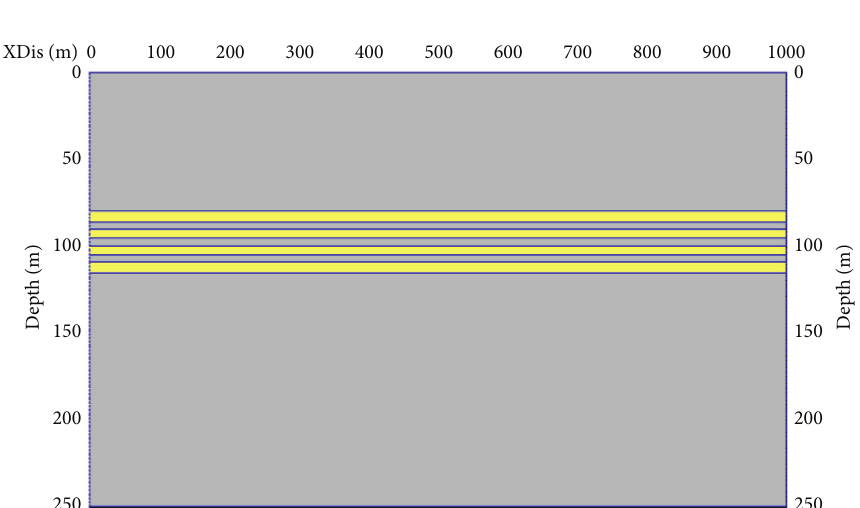
Figure 16: Geological model containing only the interference